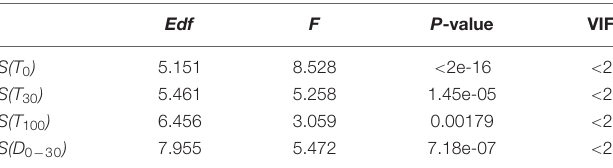
TABLE 1 | Results of the final generalized additive model (GAM) for Ommastrephes bartramii in the Northwest Pacific Ocean. Edf F P -value